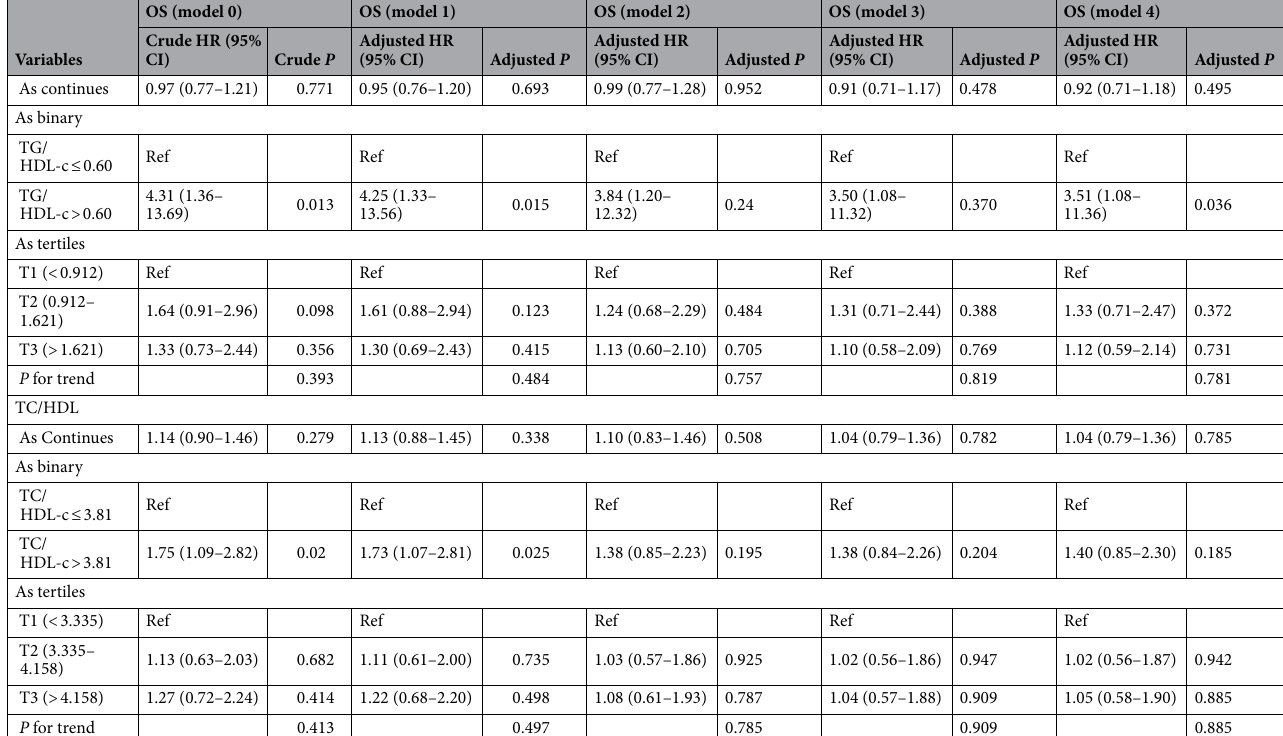
Table 2. Univariate and multivariate analysis. CRP C-reactive protein, CAR CRP/Albumin ratio, LCR lymphocyte/CRP ratio, TyG fasting triglyceride glucose index, TG triglyceride, TC total cholesterol, LHR triceps skinfold thickness. a Model 0: Unadjusted. b Model 1: Adjusted for BMI. c Model 2: Adjusted